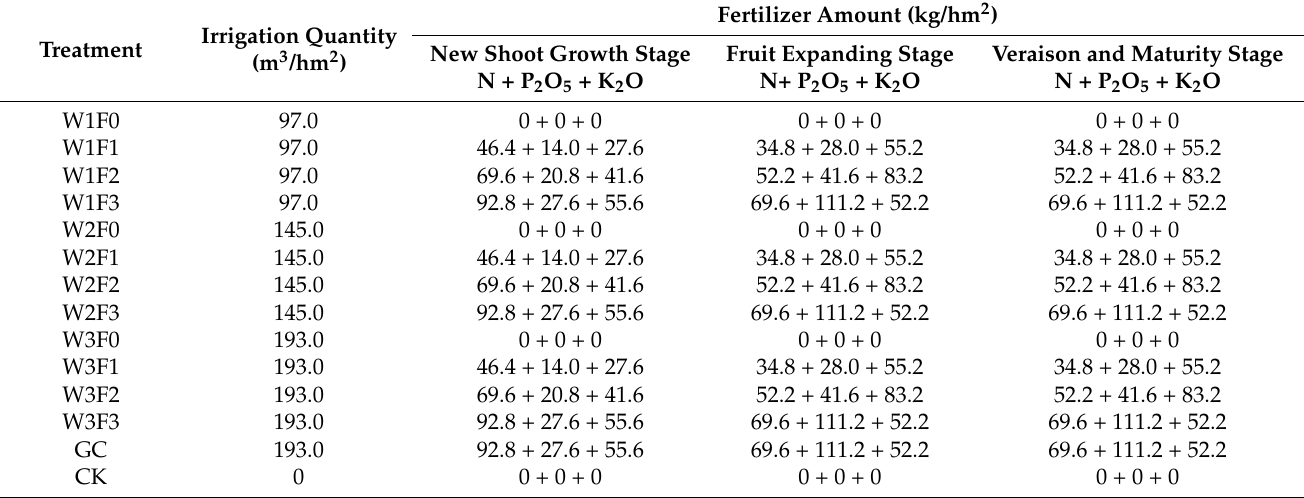
Table 2. Irrigation and fertilization of grapevine at different growth stage in